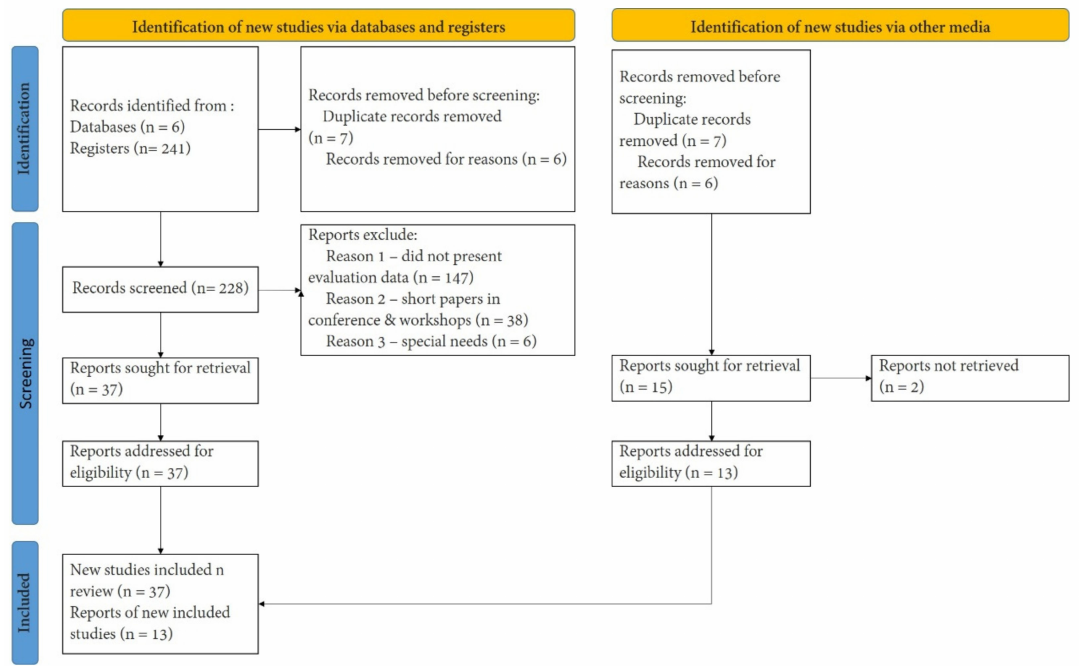
Figure 1. PRISMA 2020 flow diagram for updated systematic reviews which included searches of databases, registers and other